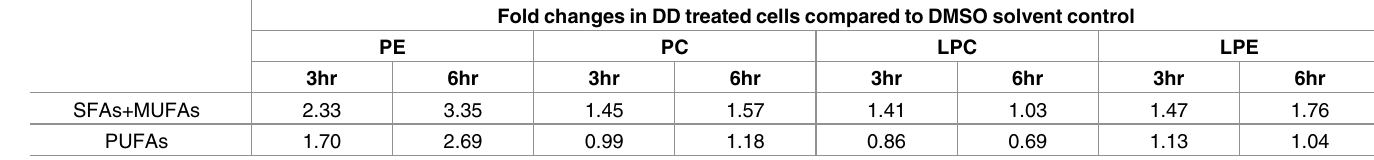
Table 5. Fold changes in lipid molecular species in PE, PC, LPE and LPC lipid classesin DD and DMSO treated cells at 3 hr and 6